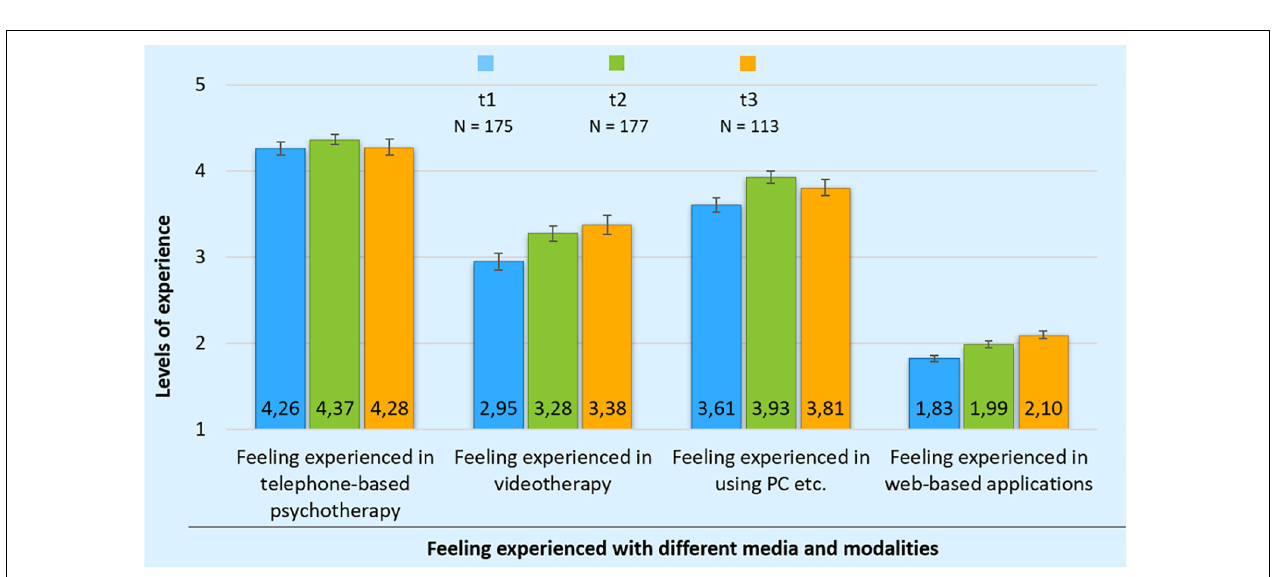
FIGURE 1 | Changes to the perceived level of experience with different media and modalities during the transition over all three test periods. Value “1” represents complete inexperience and value “5” an extremely high level of experience. N: sample size; t1–t3 test